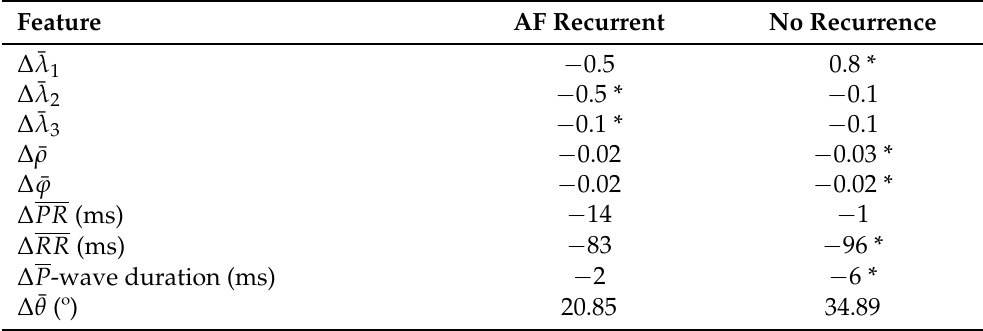
Table 5. Average changes following PVI for subset of patients who had AF recurrences (11 subjects) and those who did not have AF recurrence (39 subjects) along 2 years of follow-up. * p -value < 0.05 by paired Student’s t -test or Wilcoxon–Mann–Whitney